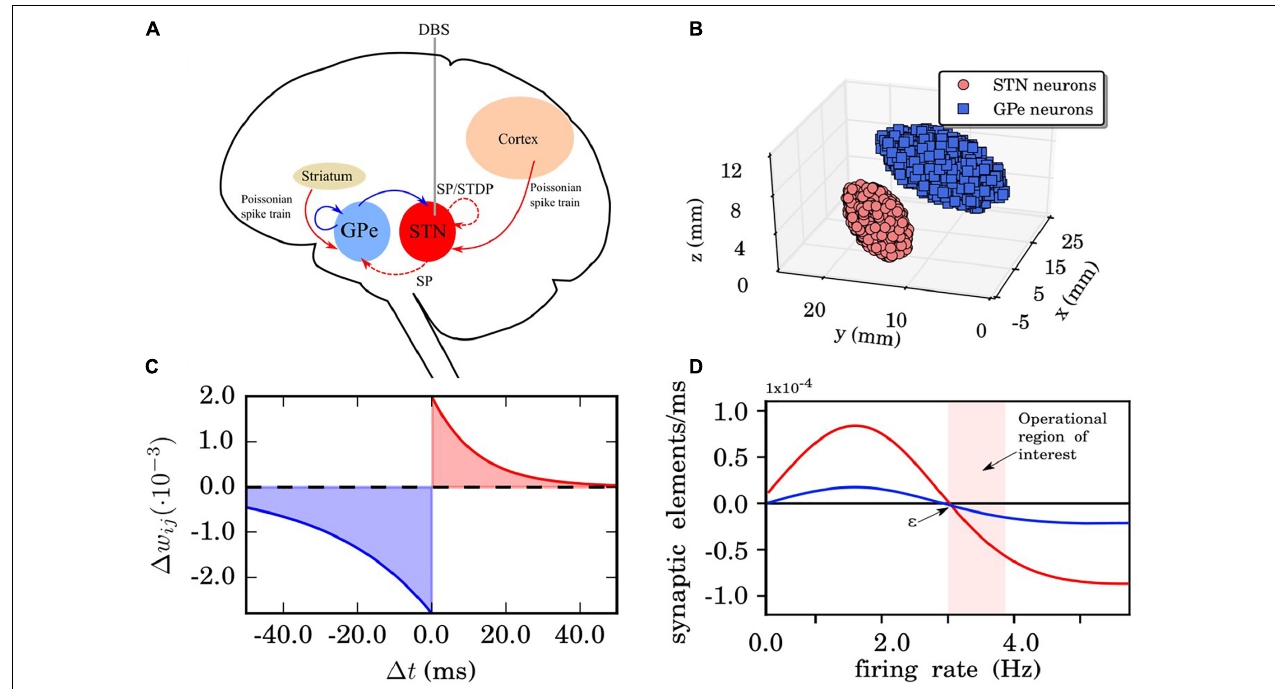
FIGURE 1 | Network, synaptic, and structural plasticity setup. (A) Structure of the model network. Excitatory synaptic connections are shown in red (with arrows) and inhibitory connections in blue (with squares). The connections whose synaptic weights do not vary in time are in solid lines. The red dashed line represents time dependent connections between the subthalamic nucleus (STN) neurons, modified by spike time-dependent plasticity (STDP) and structural plasticity. The external electrical stimulation delivered to the STN is indicated by the gray solid line. The Poissonian spike train input from the cortex to the STN is constantly active. (B) The three-dimensional STN-GPe model (left brain hemisphere). Segmented MRI slices taken from a Parkinson’s disease (PD) patient prior to deep brain stimulation (DBS) surgery. Each ellipsoid volume contains 1,000 randomly distributed point-like neurons. Note, neurons are not overlapping. (C) STDP rule for STN neurons. Synaptic connection potentiation is highlighted in red and depression in blue. (D) Growth rate curves determining the rate of creation and deletion of synaptic elements in the structural plasticity model for STN-STN connections (red) and STN-GPe connections (blue). The parameters which define the shape of the curve are the growth rate ν ε . The light red band indicates the region where the model operates during the simulations SP , which defines the peak of the curve, and the target firing rate reported in this study. These Gaussian curves correspond to Eq. (19) which represents the change in synaptic elements dz/dt as a function of the firing rate FR ( t ) . In this case, the red line has a growth rate ν SP of 0.00008 synaptic elements/ms and the blue line of 0.00002 synaptic elements/ms. The target firing rate ε in both curves is 3.0 Hz. Finally, the minimal initial firing rate η is 0.0 for both